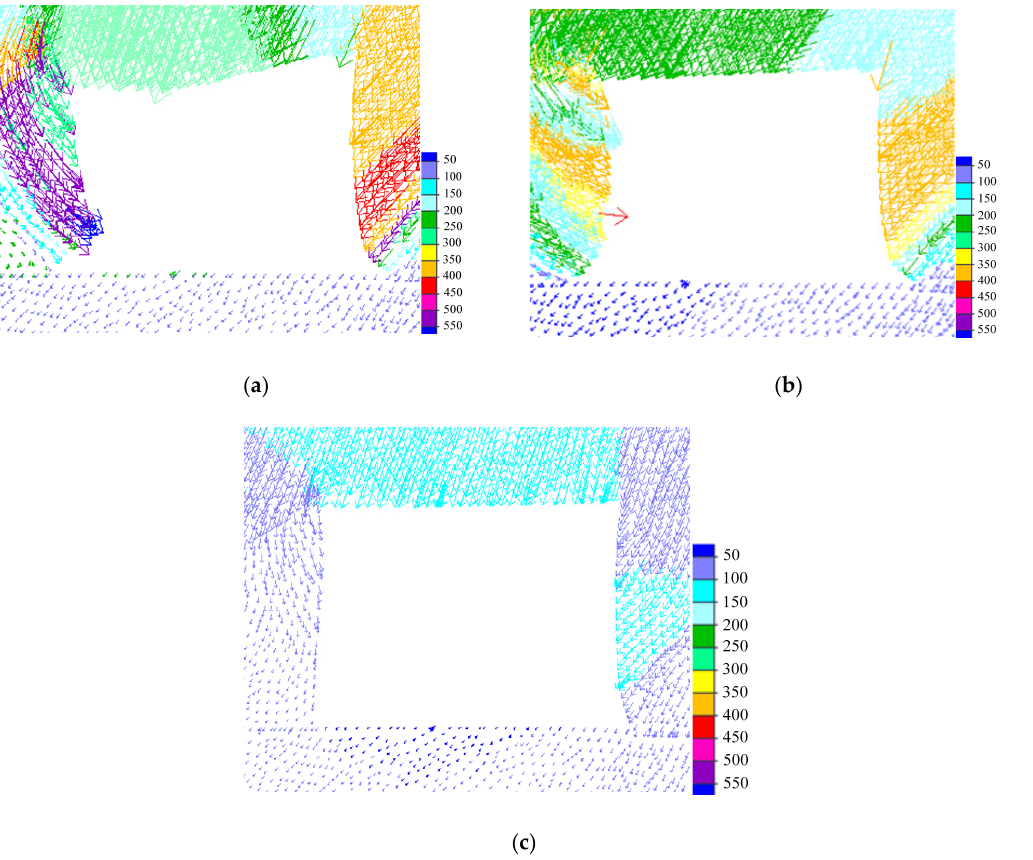
Figure 16. Simulated displacement vector map of the surrounding rock. ( a ) Primary support; ( b ) optimized support; ( c ) optimized support + roof-cutting.